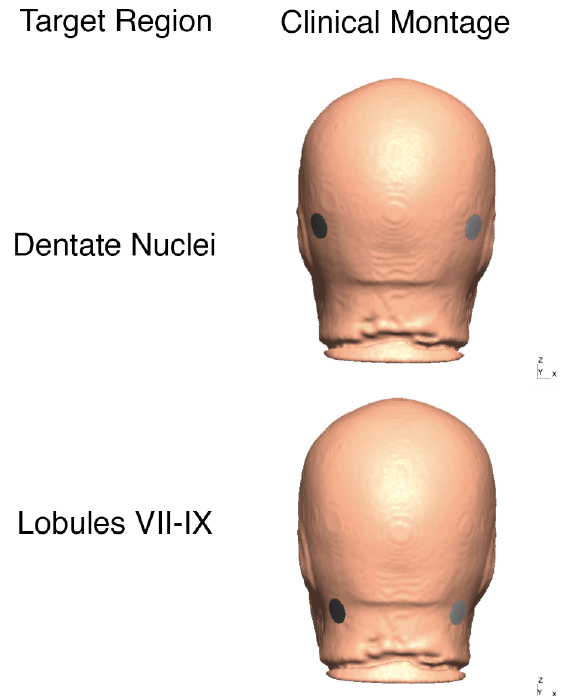
Figure 2. Clinical bilateral ctDCS montages used for FRT balance study is shown on the head model from 55 to 59 years age-group MRI template. Top panel: bipolar at PO9h-PO10h, Bottom panel: bipolar at